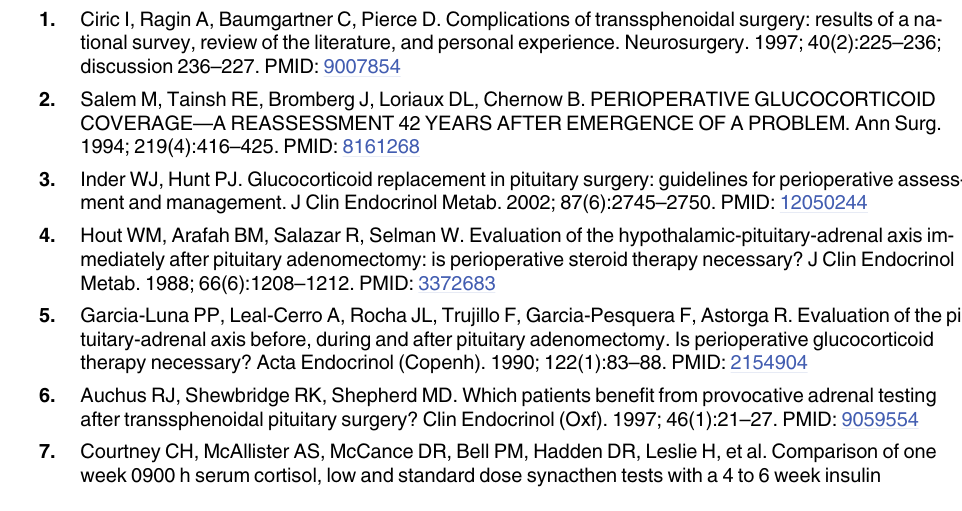
in non-ACTH-secreting pituitary adenomas by Inder and